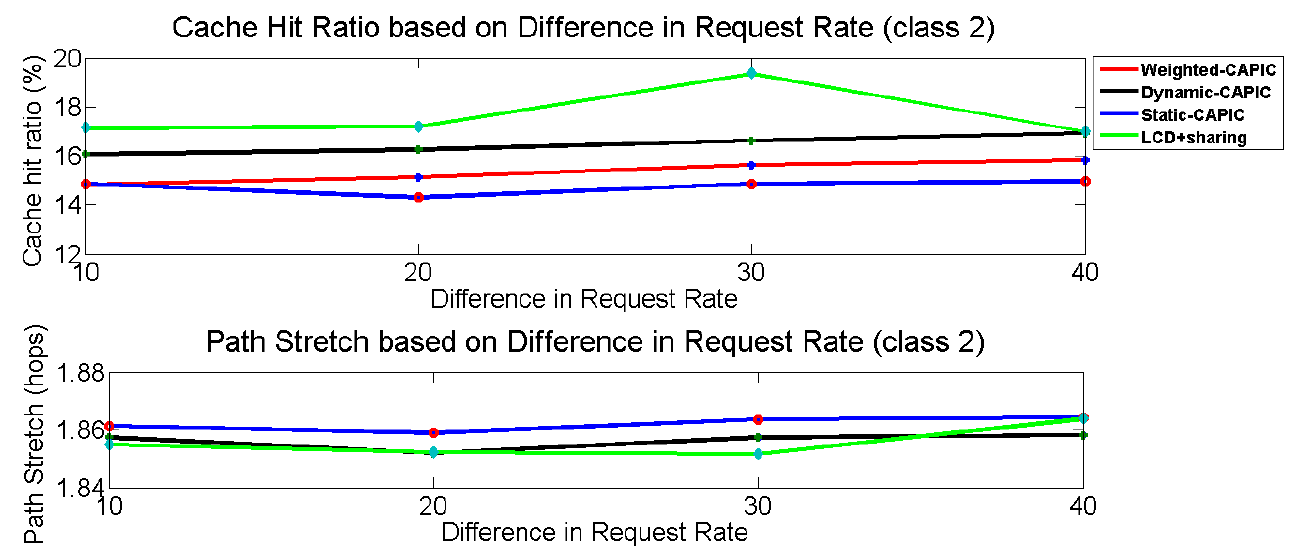
Figure 7. Cache hit ratio and path stretch of class 2 for various request rate difference.